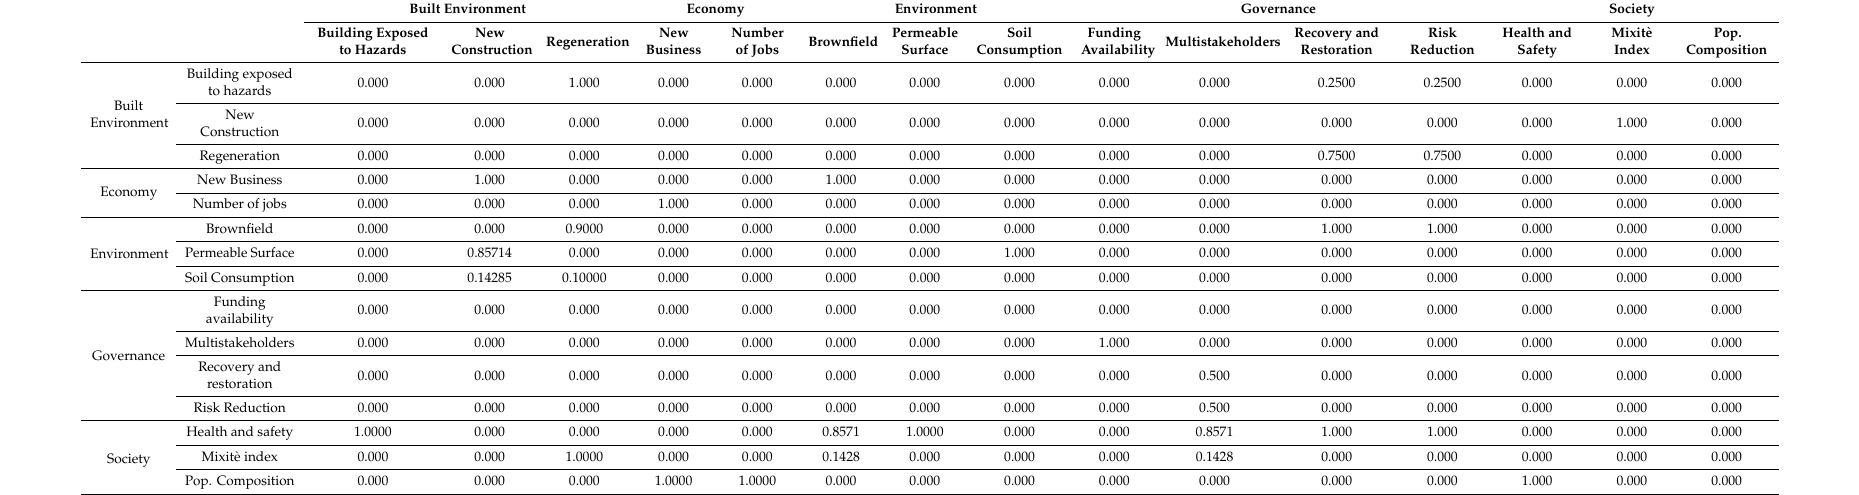
Table A2. Unweighted Super